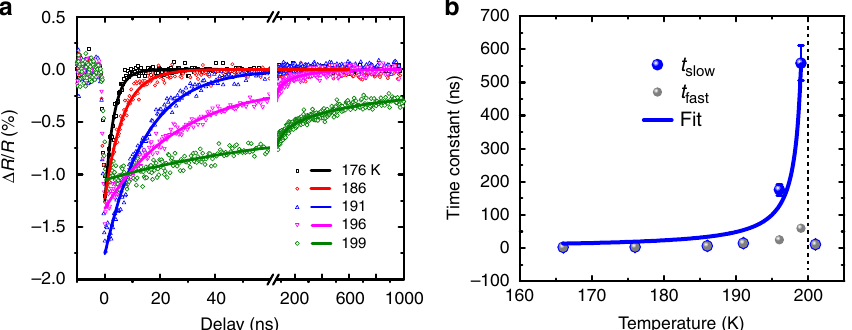
Fig. 2 Transient optical re fl ectivity measurements. a Transient re fl ectivity changes probed at the wavelength of 1100 nm at various sample temperatures. Solid lines are fi ts with the fi tting errors showing as error bars in b . b Recovery time constants of the transient re fl ectivity change as a function of sample Þ (cid:3) temperatures. The solid line is a fi t of t slow to the scaling law (cid:2) ð 1 (cid:3) T = T c